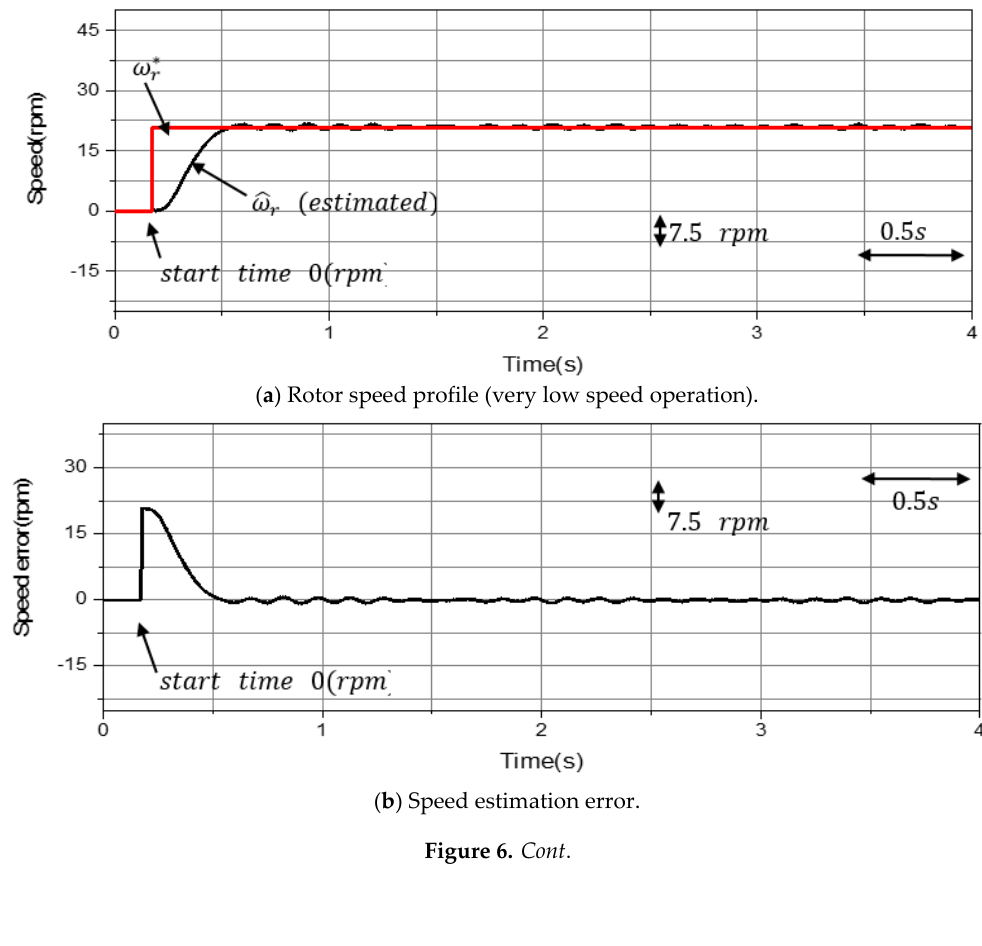
( b ) Speed estimation error. Figure 6. Cont